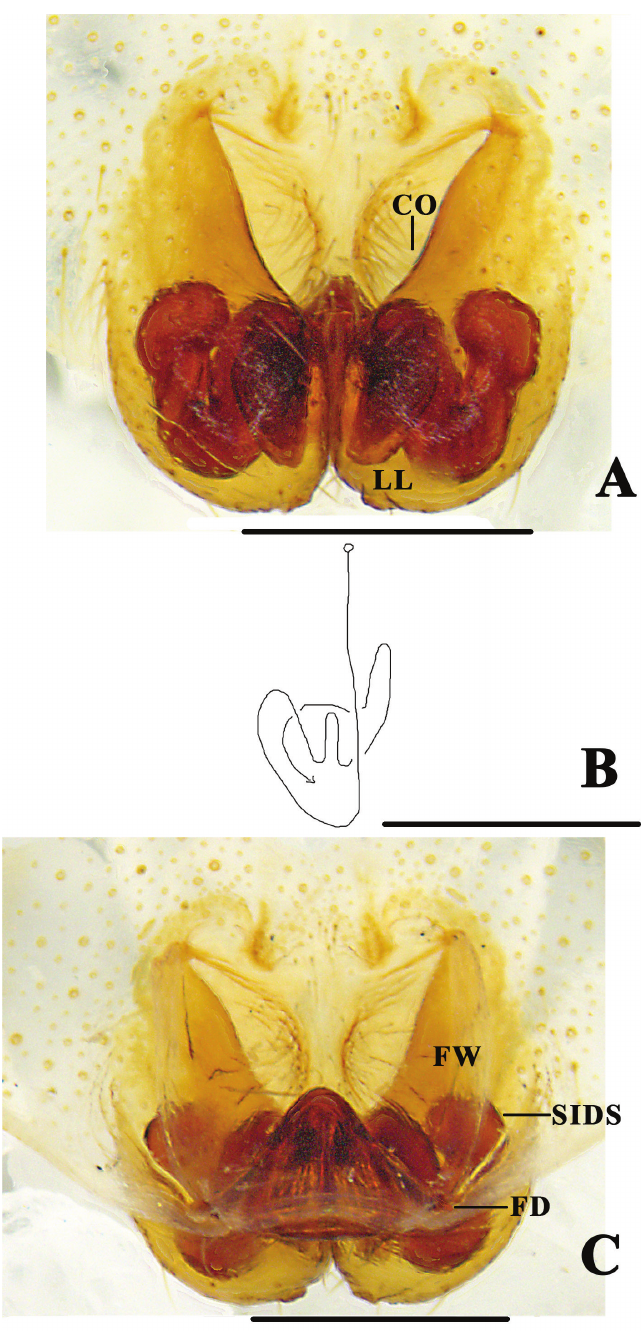
Figure 5. Pseudopoda physematosa sp. nov. A epigyne, ventral B schematic course of internal duct system, dorsal C vulva, dorsal. Abbreviations: CO–copulatory opening; FD–fertilisation duct; FW–first winding; LL–lateral lobes; SIDS–sclerotised internal duct system. Scale bars: 0.5